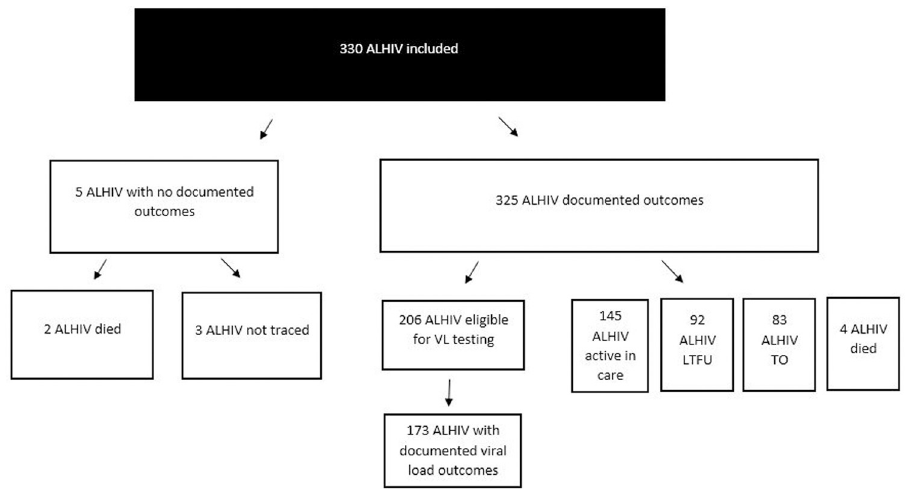
Fig 1. Flow chart of ALHIV included in the study. Active–active in care; LFTU–lost to follow up; TO- transferred out; Dead–died.